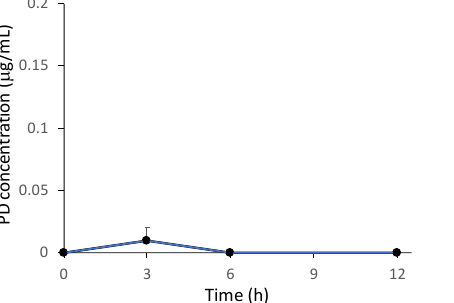
Figure 5. Time course of plasma PD levels after dosing of NG(S). Each point represents the mean ± S.E. of four rats.